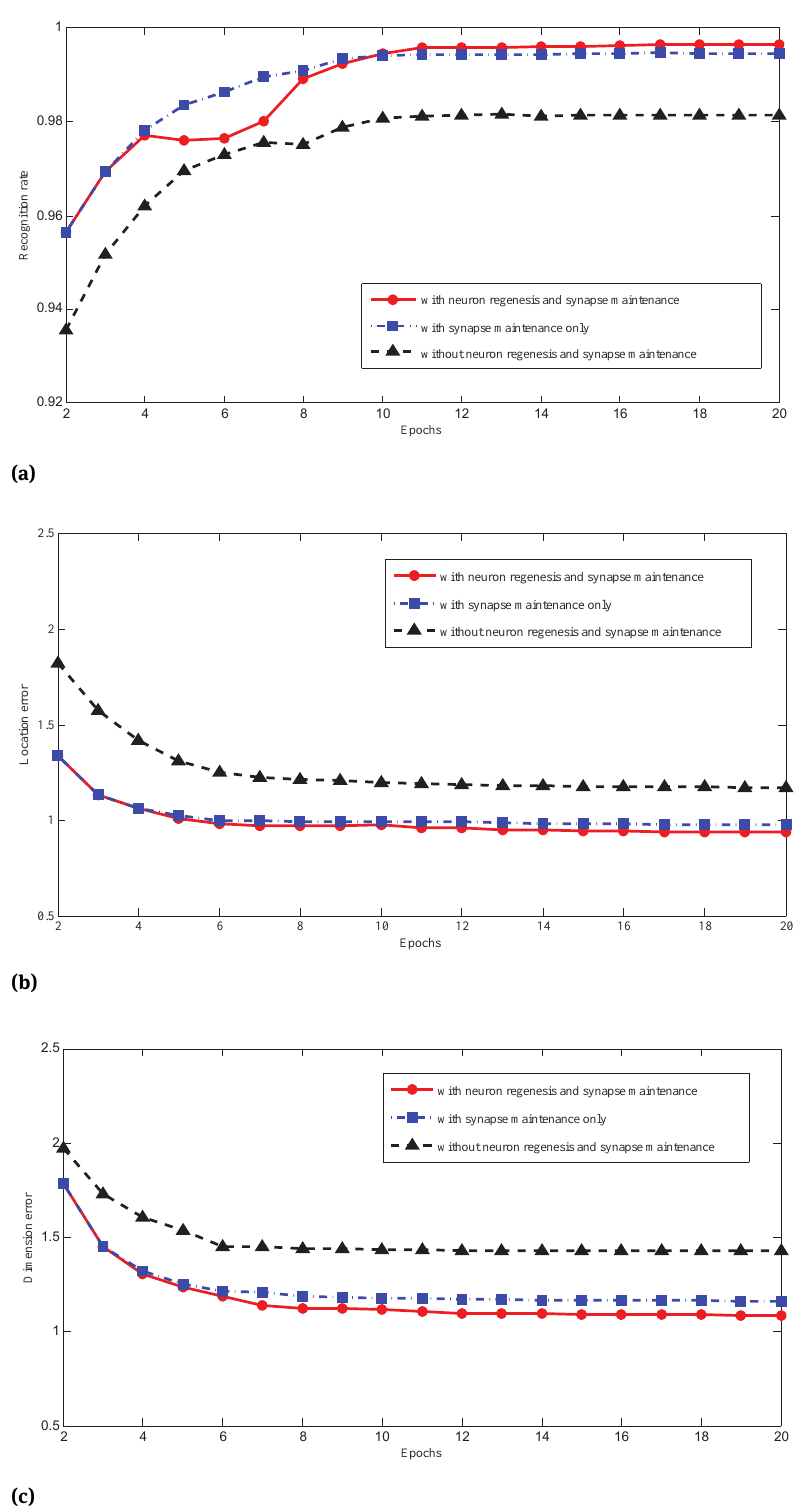
Figure 10: Face recognition rates with WWN-7 in three cases. (a) Total recognition rate, (b) location error (unit: pixel), (c) dimen- sion error (unit: